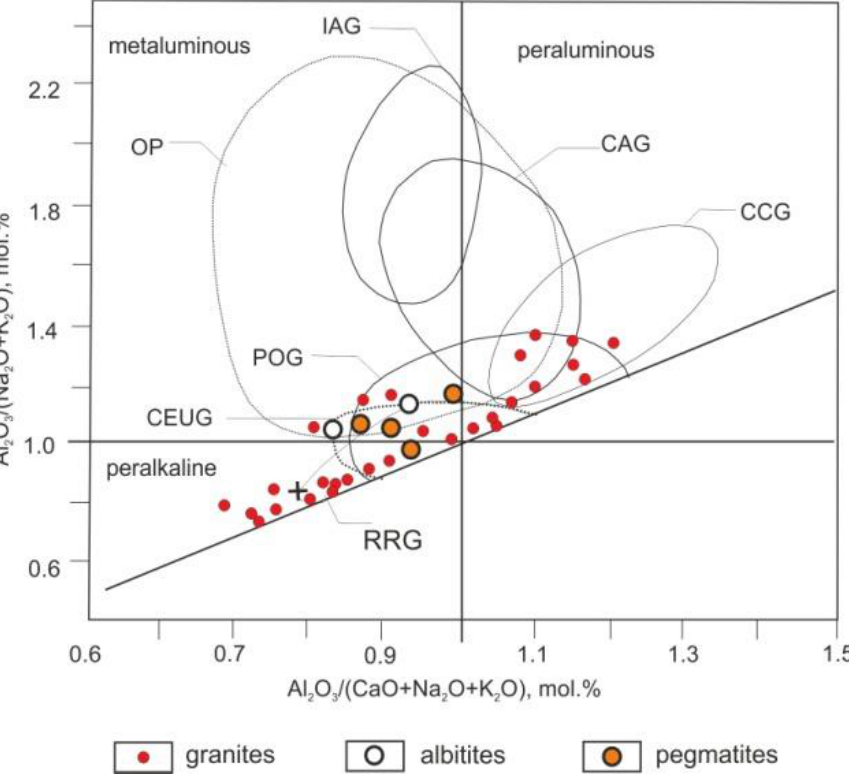
Figure 11. Al 2 O 3 /(Na 2 O + K 2 O) vs. Al 2 O 3 /(CaO + Na 2 O + K 2 O) diagram for rocks of the Somnitelnyi massif and Tommot deposit [57]. Fields include: IAG — island arcs; CAG — continental arcs; CCG — continental collision settings; POG — postorogenic; CEUG — continental epiorogenic uplifts; and RRG — rift-related.